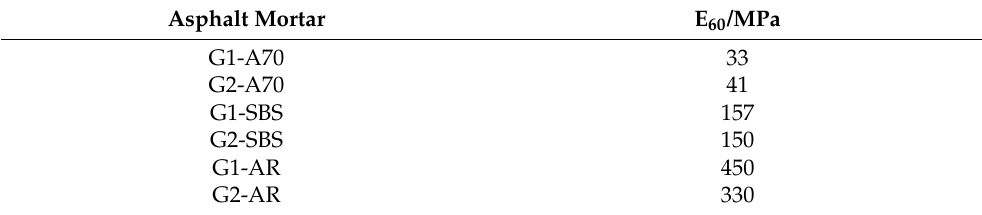
Table 4. The complex modulus at 60 ◦ C. Asphalt